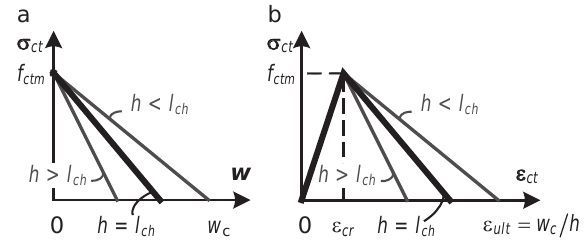
Fig. 3. FE models of beam